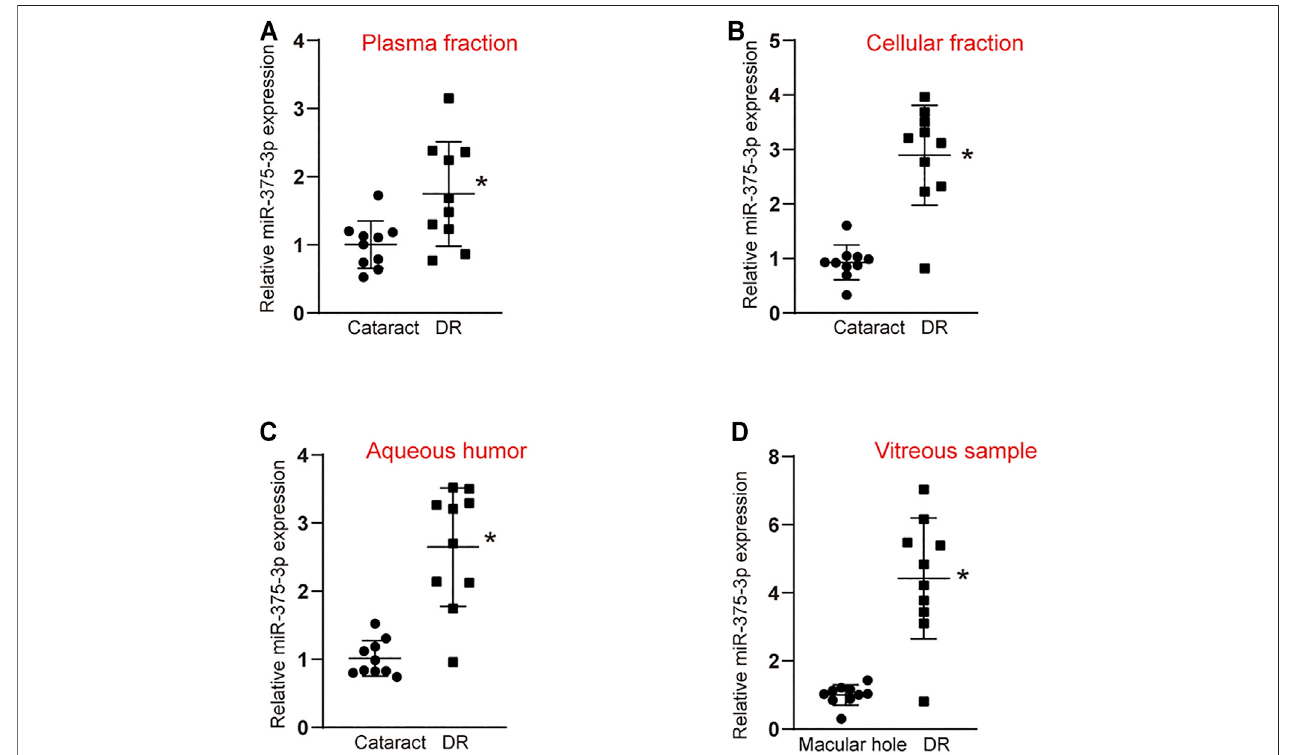
FIGURE 5 | Evaluation of the diagnostic performance of miR-375 – 3p in diabetic retinopathy. (A,B) qRT-PCR assays were conducted to detect miR-375 – 3p expressionintheplasmafraction (A) andcellularfraction (B) ofperipheralbloodofDRpatientsandcataractpatients(* p < 0.05vs.cataract,two-tailedStudent t test). (C) qRT-PCR assays were conducted to detect miR-375 – 3p expression in aqueous humor of DR patients and cataract patients (* p < 0.05, two-tailed Student t test and Bonferroni test). (D) qRT-PCR assays were conducted to detect miR-375 – 3p expression in the vitreous samples of DR patients and non-diabetic patients with macular hole (* p < 0.05, two-tailed Student t test and Bonferroni test).